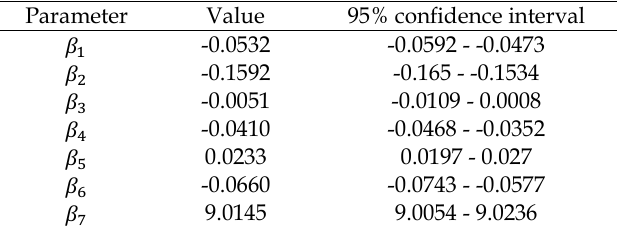
Table B3. Deterministic parameters calculated with data on daily flights 2014-2016